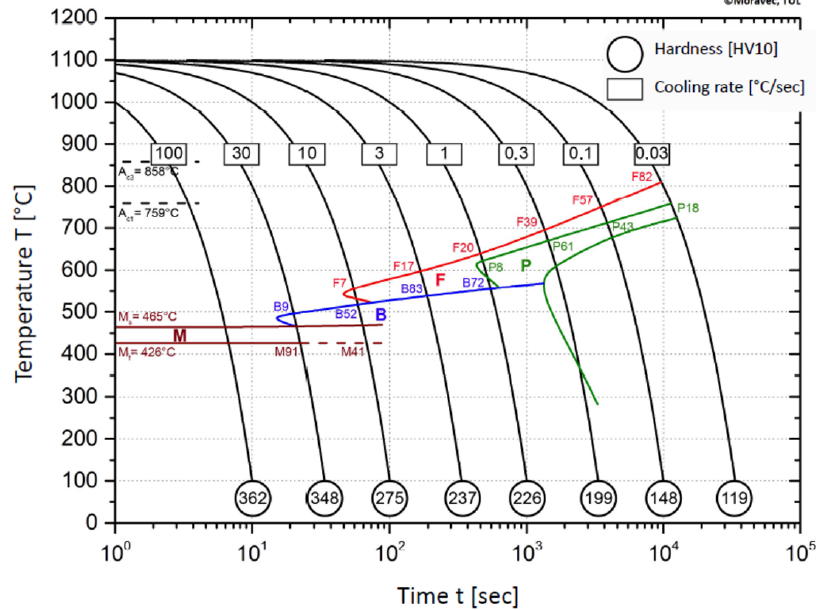
Figure 12. The CCT diagram of S960MC steel.